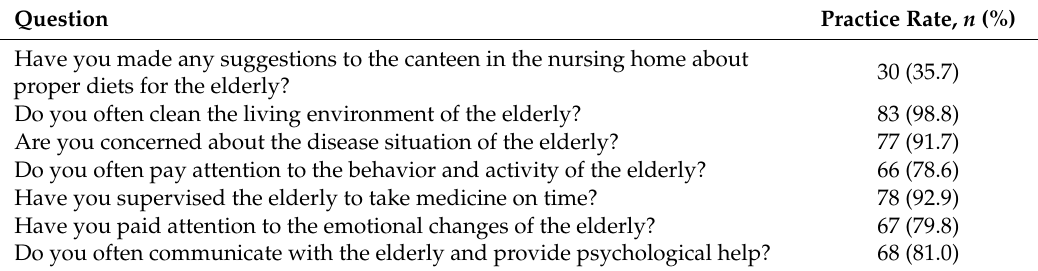
Table 4. Respondents’ practice on elderly